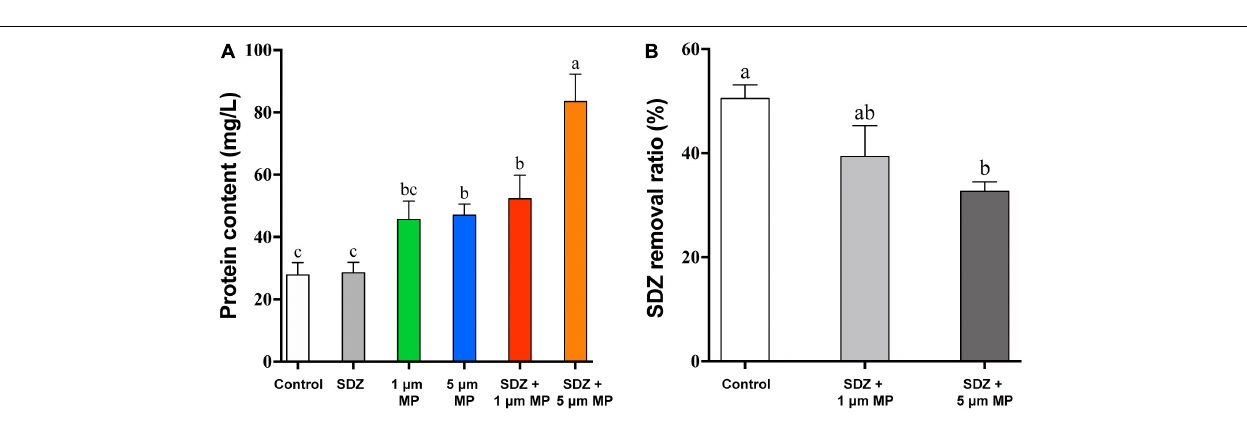
FIGURE 6 | The extracellular cellular protein content of C. reinhardtii exposed to PS-MPs (1 and 5 µ m) and/or SDZ (50 mg l − 1 ) (A) and SDZ removal ratio with different particle sizes PS-MPs coexistence (B) . Values are means ± SEM of three replicates and significant differences ( p < 0.05) are denoted with different